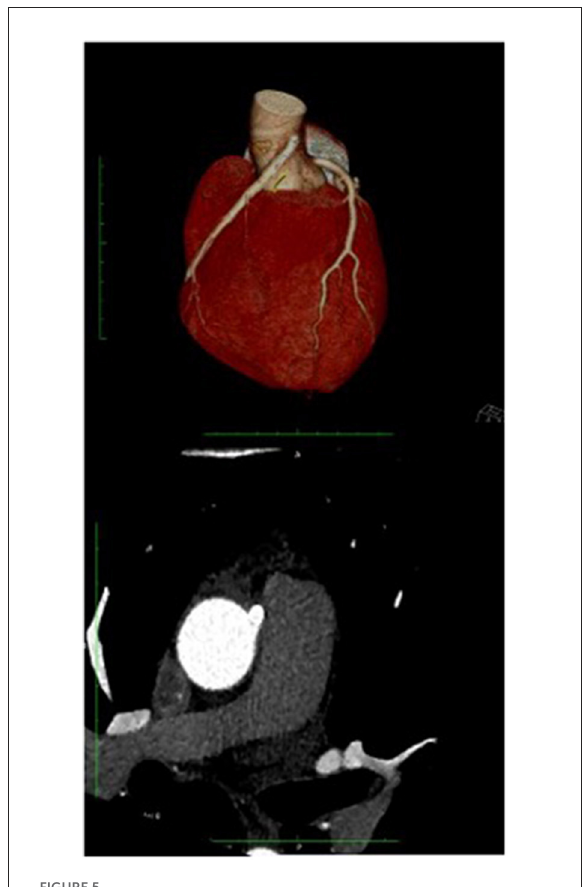
FIGURE5 Coronary TC: The coronary TC confirmed the anomalous origin from opposite site of ascending aorta 17mm from the sinotubular junction, with interarterial course. Modest effusion